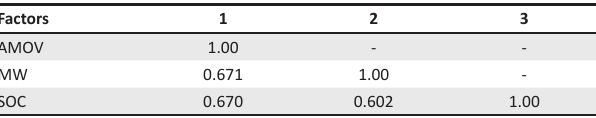
TABLE 3: Inter-factor correlations. Factors